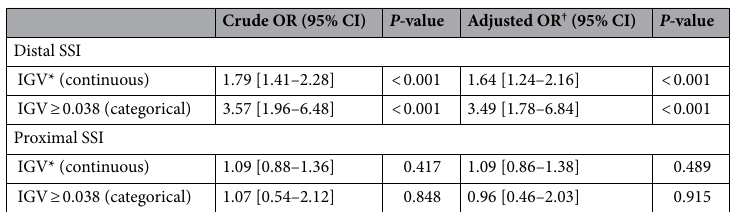
Table 4. Relationship between infarct growth velocity and early neurological deterioration according to the location of single subcortical infarction lesion. SSI single subcortical infarction, IGV infarct growth velocity. *These variables were transformed into a log scale. † These adjusted OR values were obtained by adjusting the variables with P < 0.10 as confounders in a univariate analysis performed respectively for each group of patients with SSI of different locations.